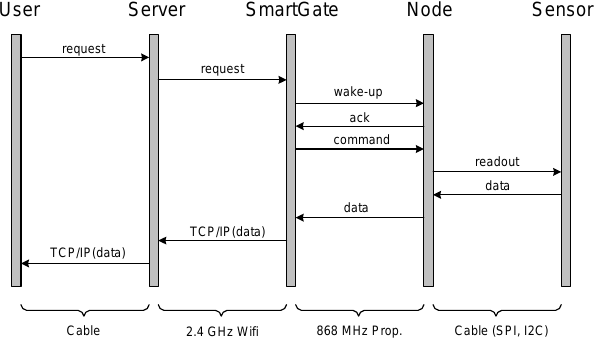
Figure 3. Command chain of the system.